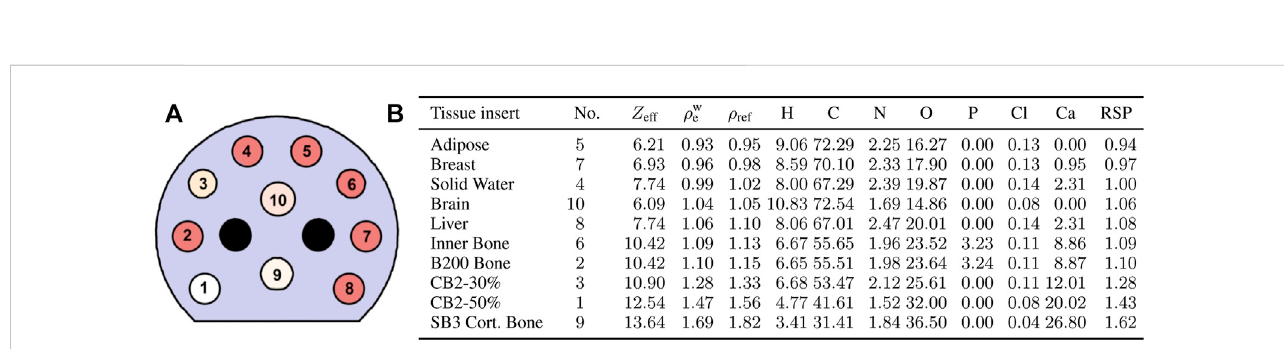
FIGURE 2 (A) Depiction of the micro-CT calibration phantom and (B) tabulation of its related properties, according to the manufacturer (SmART Scienti fi c Solutions, Netherlands): the effective atomic number Z eff , relative-to-water electron density ρ w e , mass density ρ ref , and elemental composition by the relative weight and RSP measured [23] for each tissue-mimicking